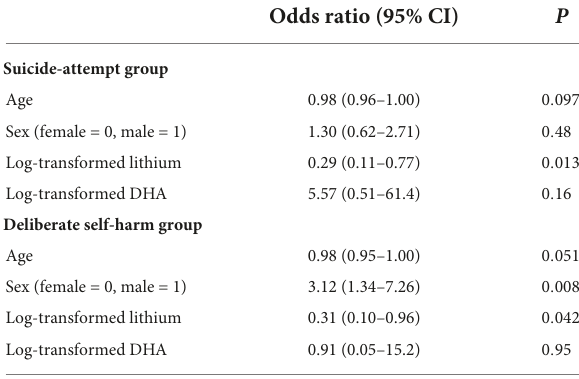
TABLE 3 Multivariate logistic regression analyses of lithium and DHA in the suicide-attempt group and deliberate self-harm group with the control group as a reference.